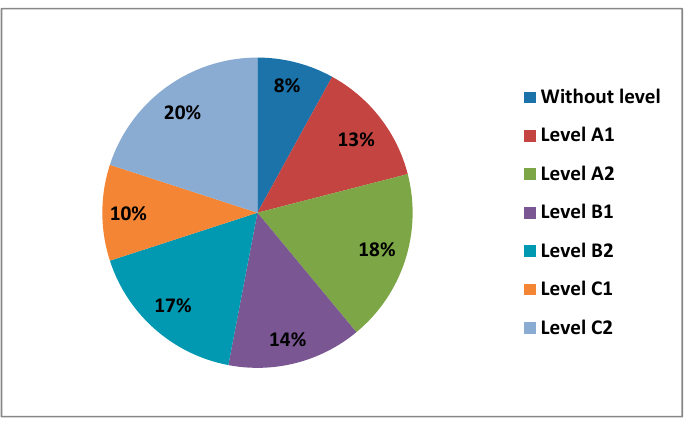
Figure 9. Average levels of digital teaching competence.